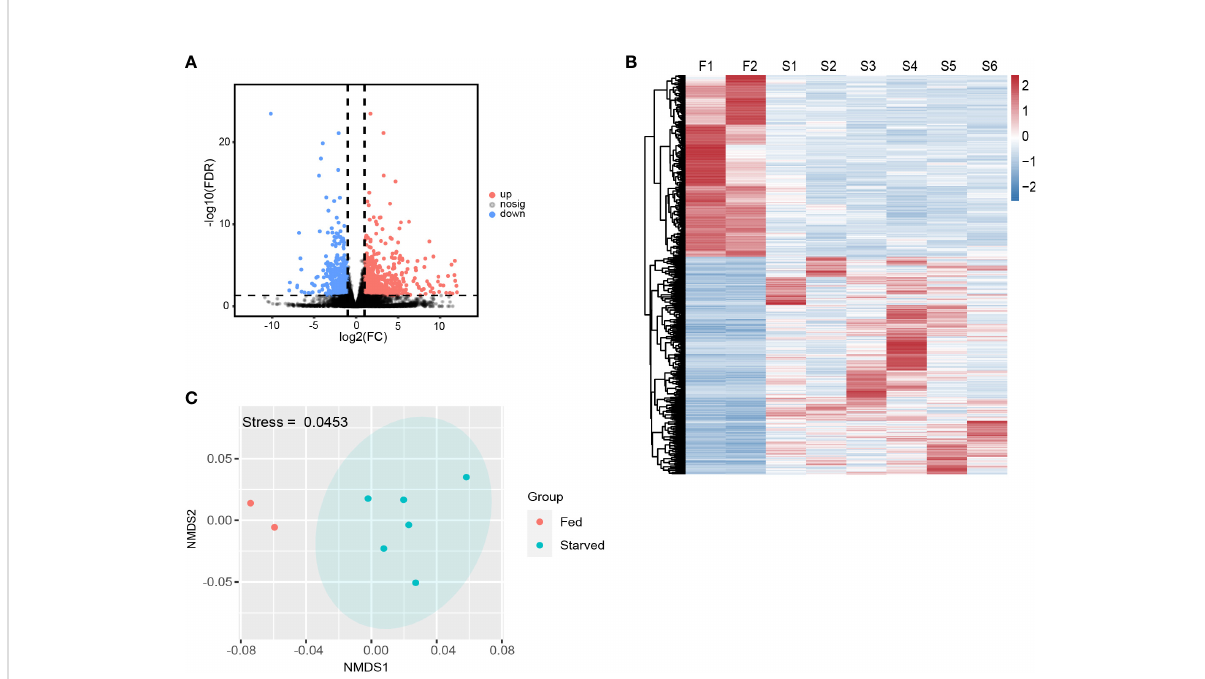
FIGURE 2 Overall DEGs expressions in starved and fed CoTS. (A) Volcano map of differential genes in transcriptome (FDR < 0.05, |log2(fold change)| ≥ 1). (B) Heatmap of the DEGs in fed and starved CoTS individuals (F = fed CoTS, n = 2; S = starved CoTS, n = 6). (C) Nonmetric multidimensional scaling (NMDS) plot of DEGs among fed and starved CoTS